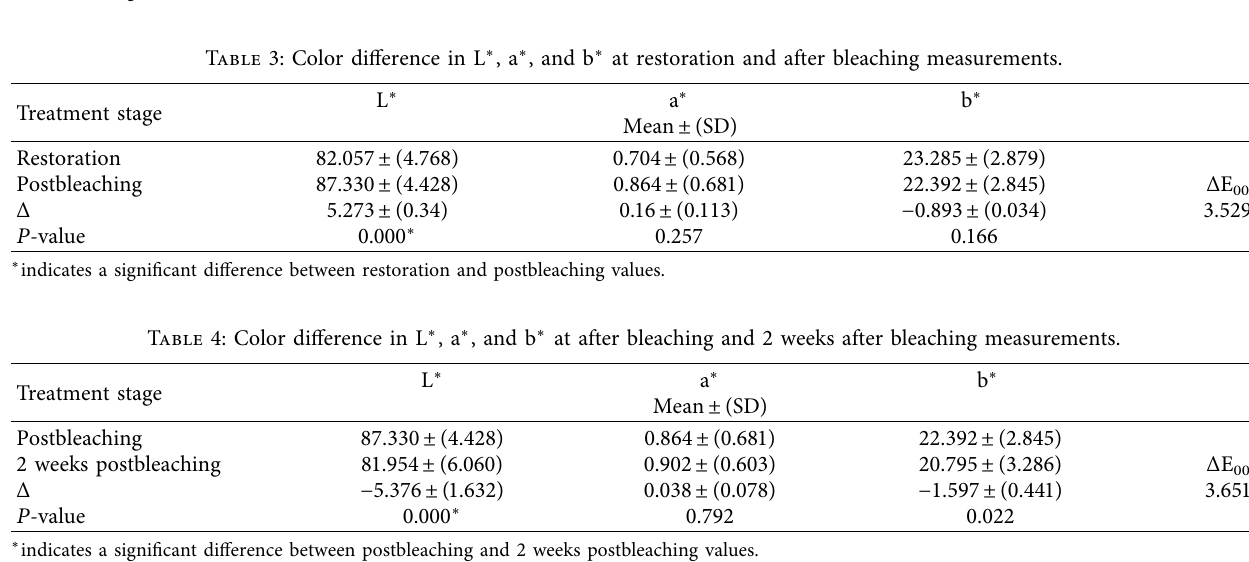
Table 2: Color difference in L ∗ , a ∗ , and b ∗ at tooth structure and restoration measurements. Treatment stage